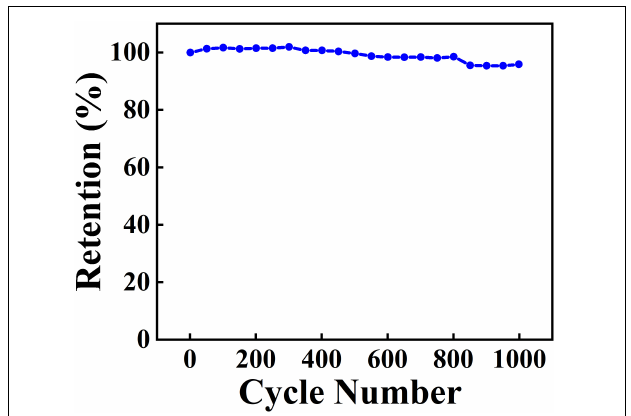
FIGURE 6 | Galvanostatic charge-discharge curves at current densities of (a) 3, (b) 5, (c) 7, (d) 10 mA cm − 2 for Zn-Fe-DH -MWCNT.